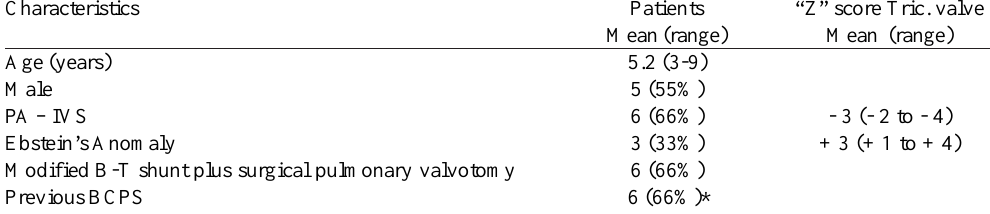
Table 1. Preoperative characteristics of